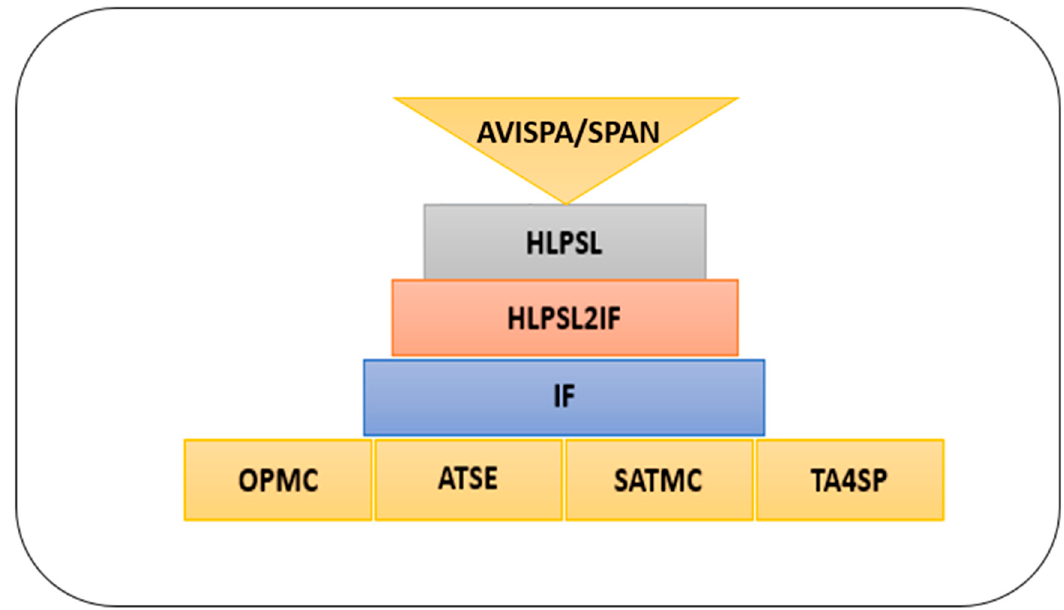
Figure 2. AVISPA Push-bottom Flow.